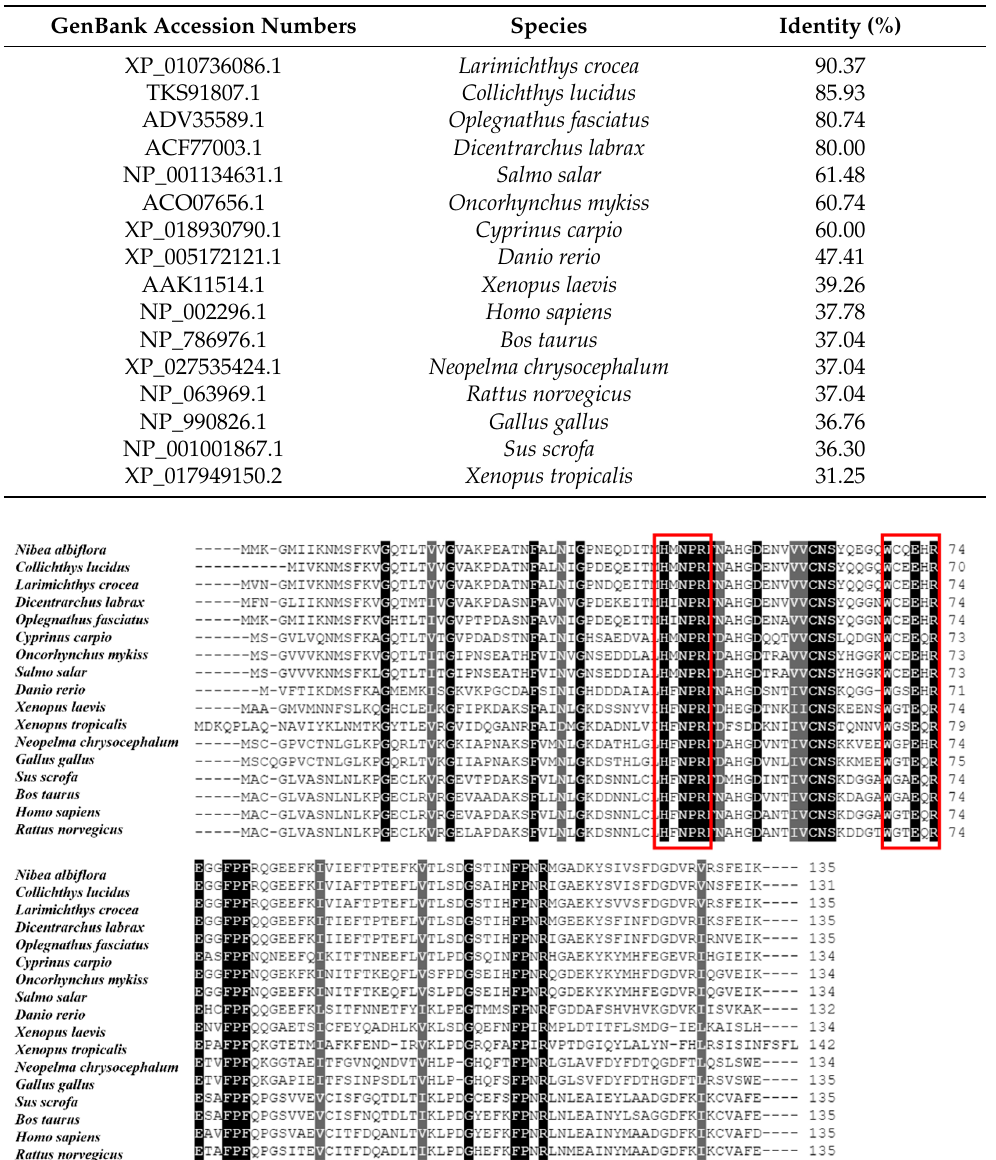
Figure 1. The sequence and structure analysis of NaGal ‐ 1 . ( A ) The diagram of NaGal ‐ 1 gene structure in N. albiflora . The squares in different color within the arrow area represent the different exons of NaGal ‐ 1 gene and the white squares represent introns. The lengths of exons are shown on the top . ( B ) The stop codons were indicated with asterisk (*), the CRD was highlighted in yellow shade, the sugar binding motifs H ‐ NPR and W ‐‐ E ‐ R were underlined, the green boxes indicate Ser phosphor ‐ ylation sites, the blue boxes indicate Thr phosphorylation sites, the purple boxes indicate Tyr phos ‐ phorylation sites. ( C ) Tertiary structure of Na Gal ‐ 1 protein is a homodimer, two conserved β ‐ galac ‐ toside binding motifs (HFNPR and WGPEER), C ‐ terminus and N ‐ terminus, and ligands (NDG ‐ GAL) are labeled with arrows. β ‐ sheets, random coils, and β ‐ turns are shown in yellow, green, and purple, respectively.